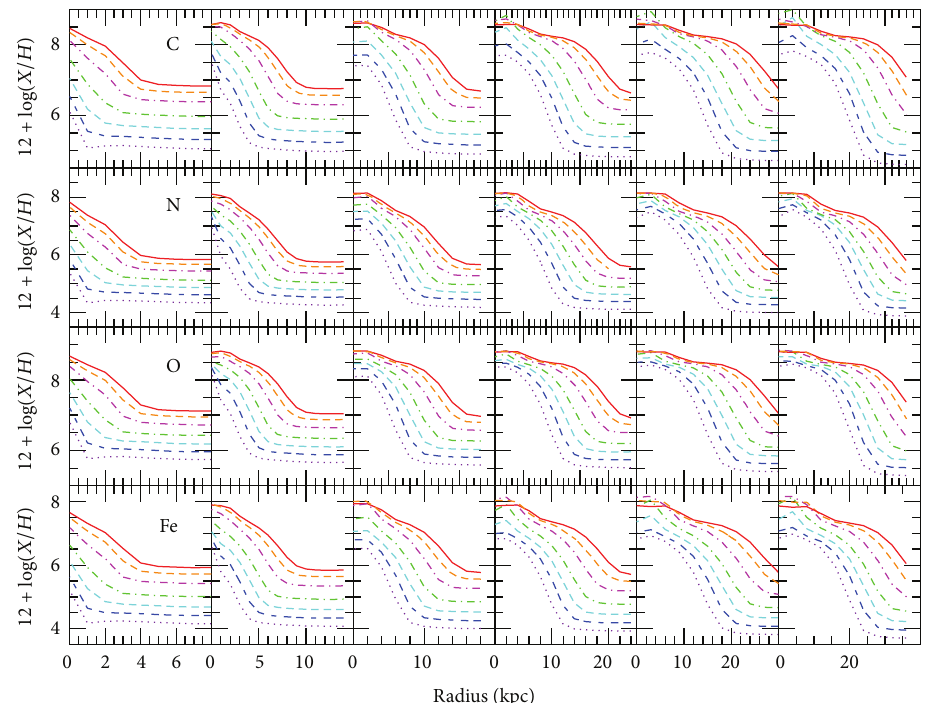
Figure 7: Evolution with redshift of radial distributions of elemental abundances, C, N, O, and Fe from top to bottom. Each column shows the results for a theoretical galaxy of Table 1, from the galaxy, with 𝑉 max = 78 kms −1 , at left to the most massive one with 𝑉 max = 290 km s −1 at the right. In each panel distributions for 7 redshifts are shown, with the same color coding as in Figure